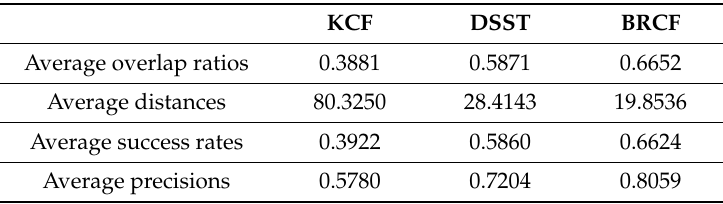
Table 1. Comparison of three methods on the average overlap ratio, the average distance, the average success rate, and the average